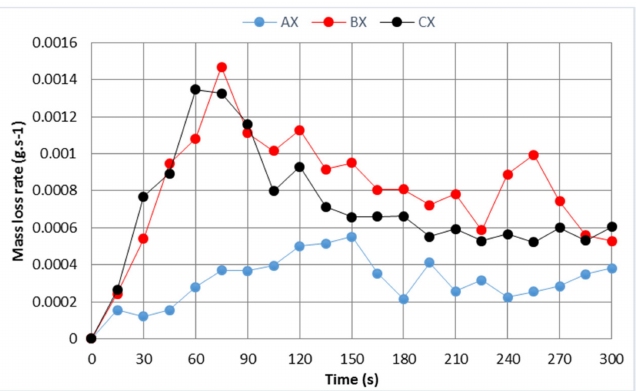
Figure 7. This is a figure. Schemes follow the same formatting. Note: The value X represents the average value of all samples in each group.